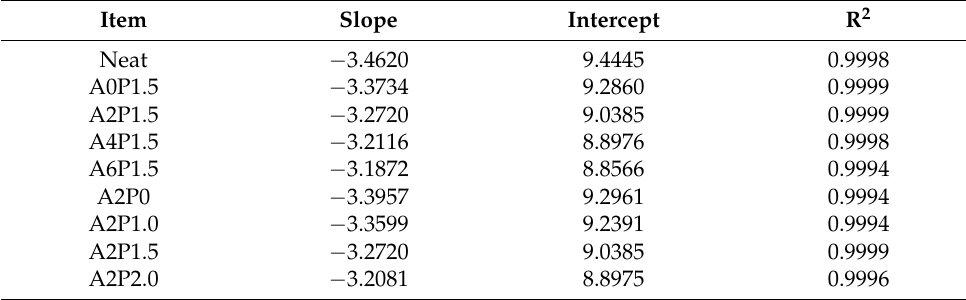
Table 6. The mixing and compaction temperatures for all samples.